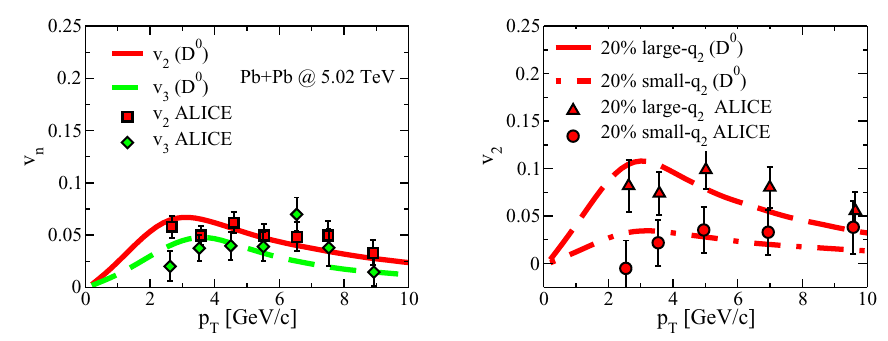
Figure 1. Left panel: D meson v 2 ( p T )(red solid line) and v 3 ( p T )(green dashed line) as function of p T at 0 10% centrality class for Pb + Pb √ s = 5 . 02 TeV . Right panel: D meson v 2 ( p T ) at large (red − dashed line) and small (red dot-dashed line) q 2 selection as function of p T in the same centrality class. Experimental data have been taken from Ref.s [7, 8].